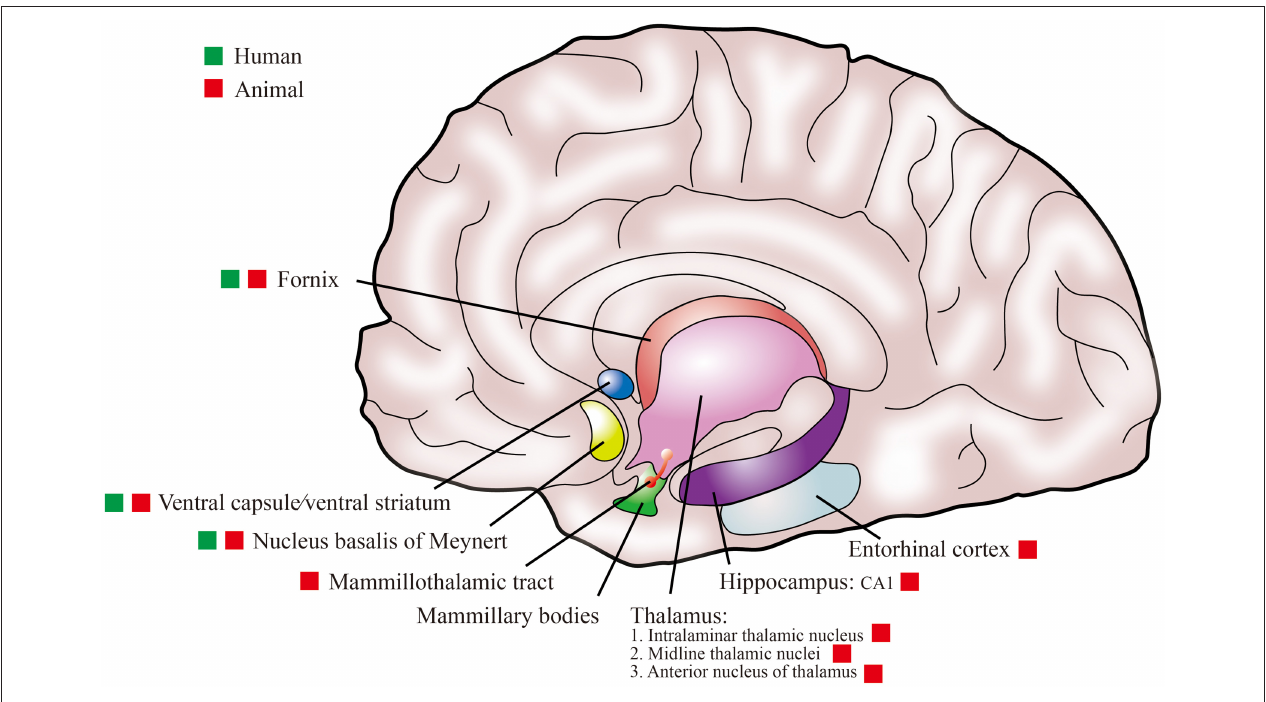
FIGURE 2 | The schematic diagram of the stimulation targets for DBS in